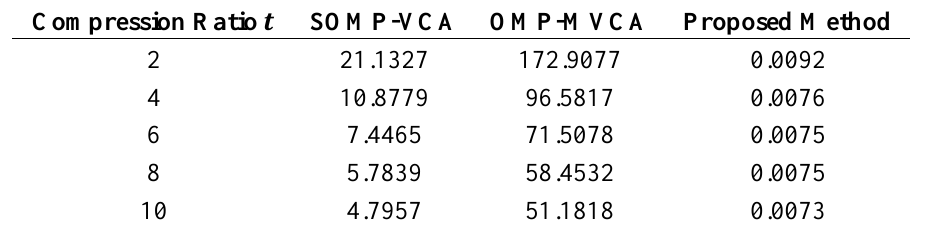
Table 6. Rural HSI: average runtime consumed by the two methods for estimating the endmembers. Compression Ratio 𝒕